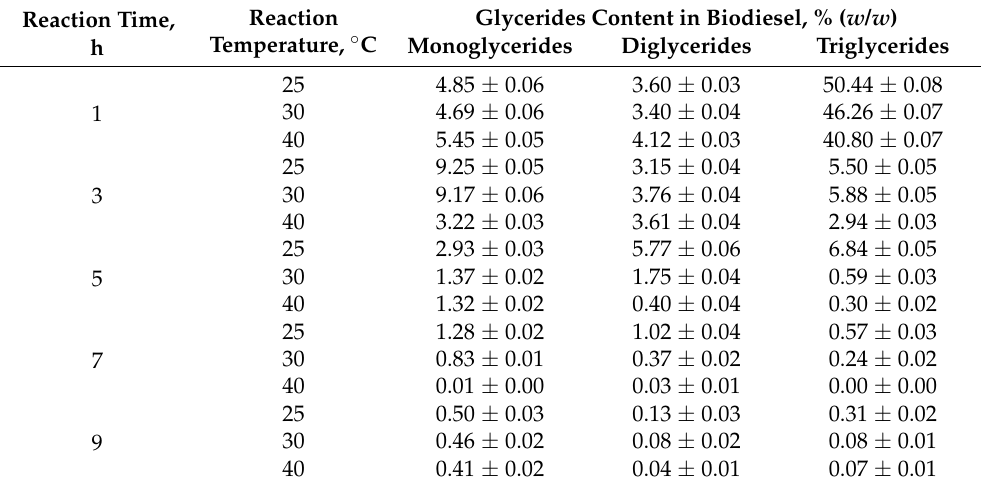
Table 3. Dependence of glyceride content in reaction product on reaction temperature and duration. Reaction Glycerides Content in Biodiesel, % ( w / w ) Reaction Time, Temperature, ◦ C Monoglycerides Diglycerides h